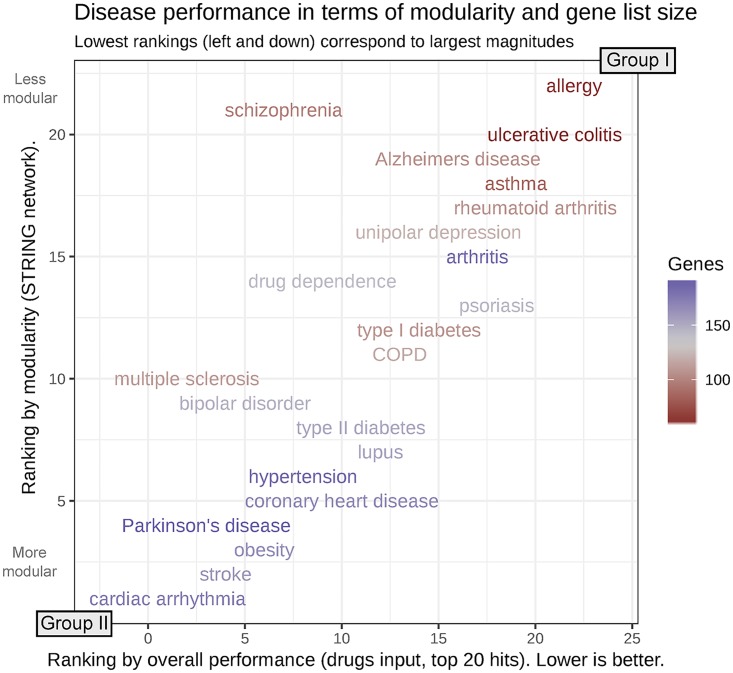
Disease performance in terms of input size and modularity.Disease performance ranked by the number of known target genes and their modularity (obtained using the igraph package, see Figure F in S1 Appendix). Modularity is a measure of the tendency of known target genes to form modules or clusters in the network. Diseases have been ranked using their explanatory model coefficient from the top 20 hits metric with known drug targets as input (x axis) and their modularity (y axis). As discussed in the text, best predicted diseases tend to have longer gene lists and be highly modular.